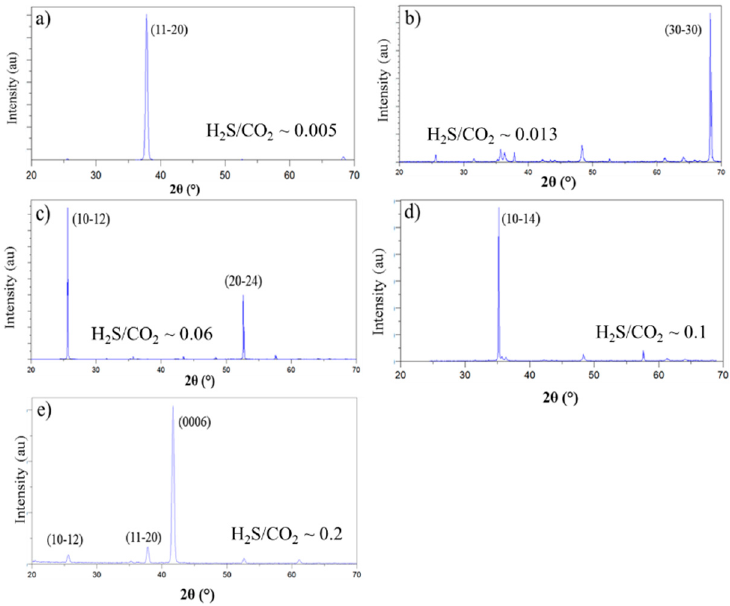
Figure 5. X-ray di ff ragtograms of coatings a, b, c, d and e. Coating ( a) H 2 S = 0.03 vol % and CO 2 = 6.25 vol %. Coating ( b ) H 2 S = 0.08 vol % and CO 2 = 6.25 vol %. Coating ( c ) H 2 S = 0.2 vol % and CO 2 = 3.25 vol %. Coating ( d ) H 2 S = 0.7 vol % and CO 2 = 6,25 vol %. Coating ( e ) H 2 S = 0.7 vol % and CO 2 = 3.25 vol %.